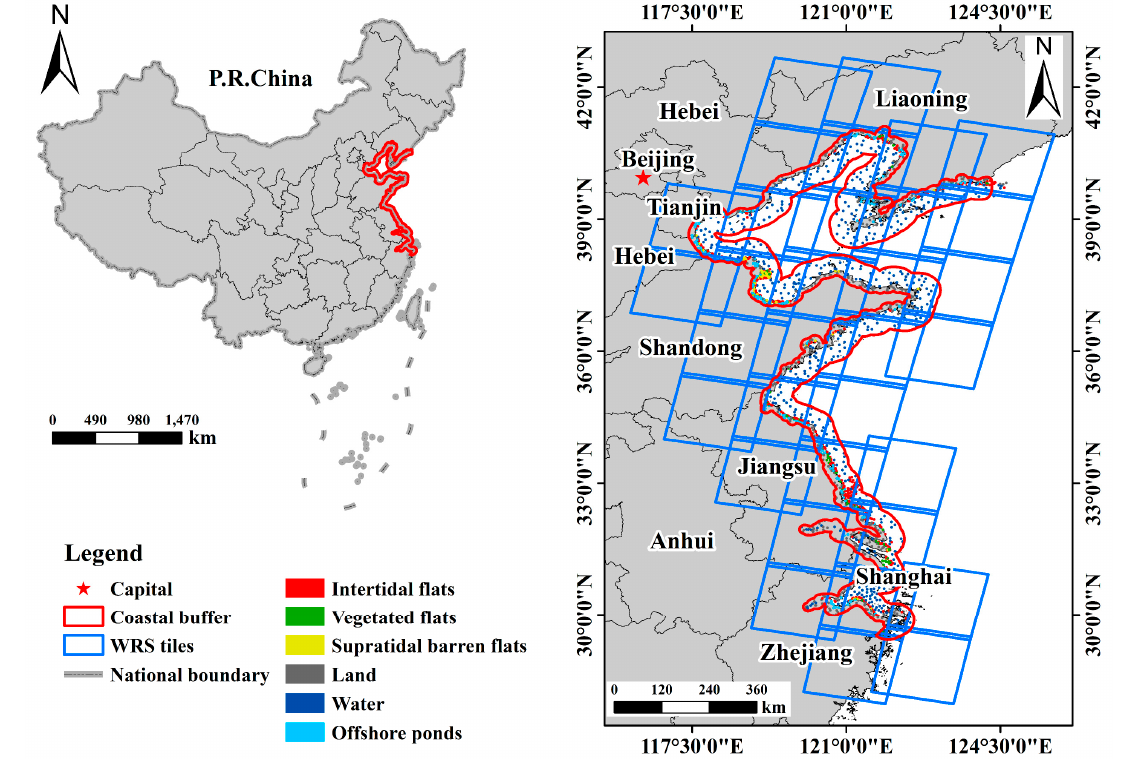
Figure 2. Location of study area, a 50 km coastal buffer for mapping tidal flats and tiles of Worldwide Reference System 2 (WRS-2) path/row covering the buffer area from Hangzhou Bay to Yalu River in China’s eastern coastal zone. Points of interest (POIs, including training and validation sample points) were marked by colored points within this figure.